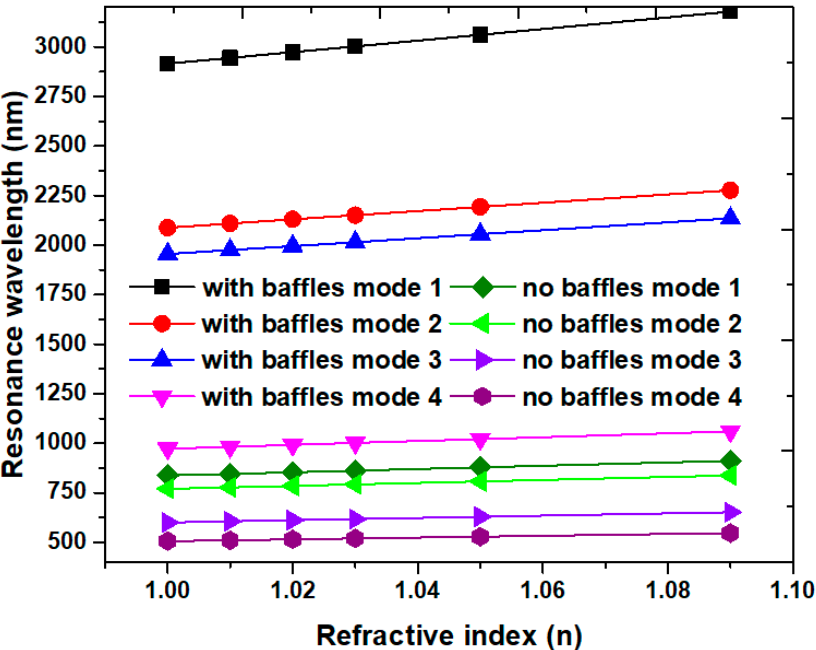
Figure 6. Illustration of the resonance wavelength ( λ res ) versus the refractive index (n) of the cases without and with Ag baffles concerning L = 600 nm in mode 1 to mode 4, respectively. The other structural parameters w, g , and d are 50, 10, and 30 nm.